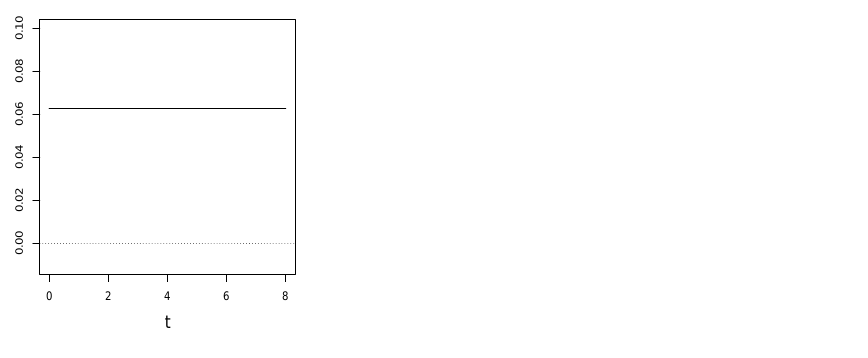
Figure 6. Resulted MIC from the counter example of the proof for Corollary